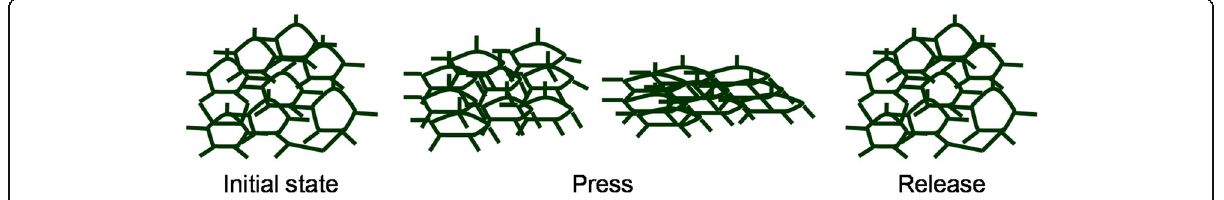
Fig. 7 Pressure-sensing schematic of PANI/sponge composite